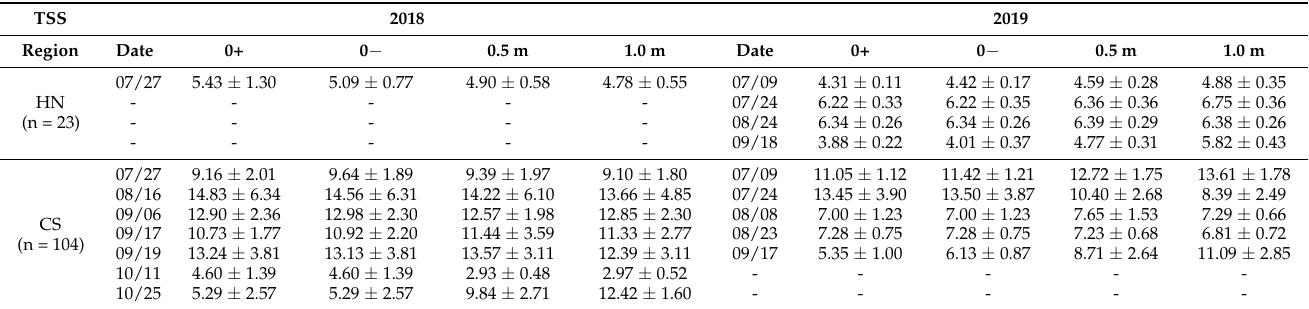
Table A2. Observed TSS in HN and CS